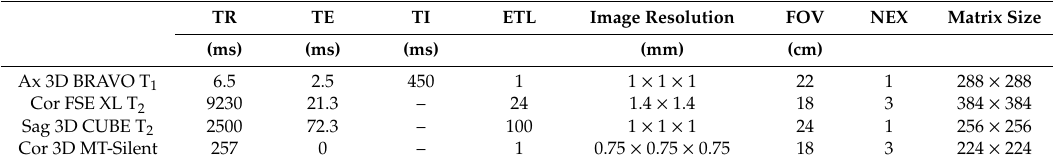
Table 1. Parameters of the imaging protocol.